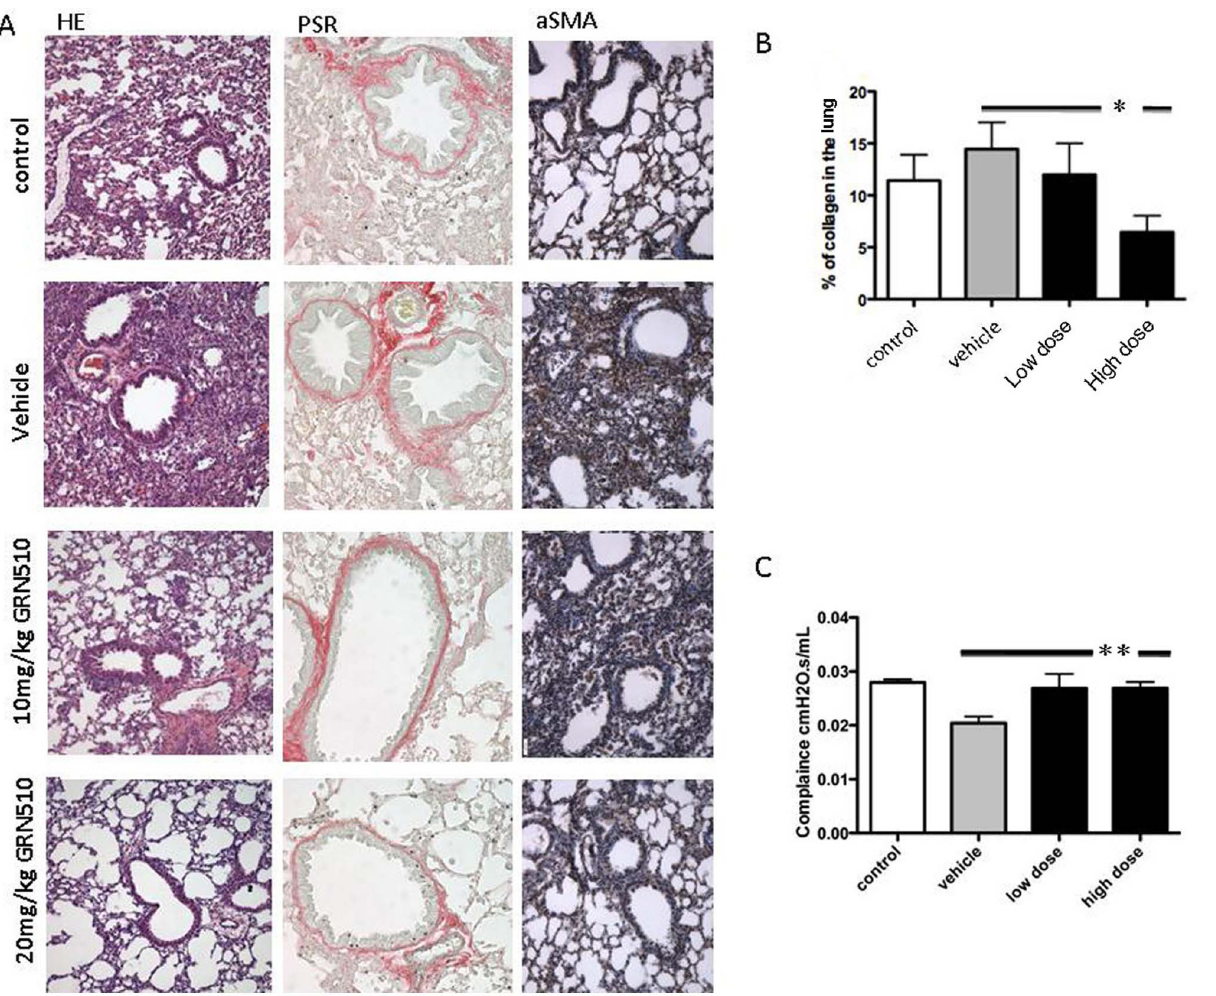
Figure 3. Reduced fibrotic response in bleomycin-injured lungs after treatment with GRN510. A. Tert Het mice were treated with GRN510 for 3 weeks at the indicated dose and subjected to bleomycin-induced fibrosis (day 0). Representative histological sections from the whole left pulmonary lobe were taken from each animal after 3 weeks of dosing and stained with H&E (Left panel), picrosirius red (middle panel), and a-SMA (Right panel). All these stainings indicate that treatment with GRN510 attenuates the bleomycin injury and in a dose dependent manner. B. Levels of picrosirius red staining were quantified with ImagePro software. Asterisk, * denotes significance amongst indicated groups (P=0.01, 1-way ANOVA) C. Dynamic compliance (ml/cm H2O) was significantly increased in the lungs of bleomycin-treated Tert Het mice. This increase in compliance was attenuated after GRN510 treatment 3 weeks after bleomycin injury (P=0.01; 1-way ANOVA). N=4–10 animals per group, values given are mean 6